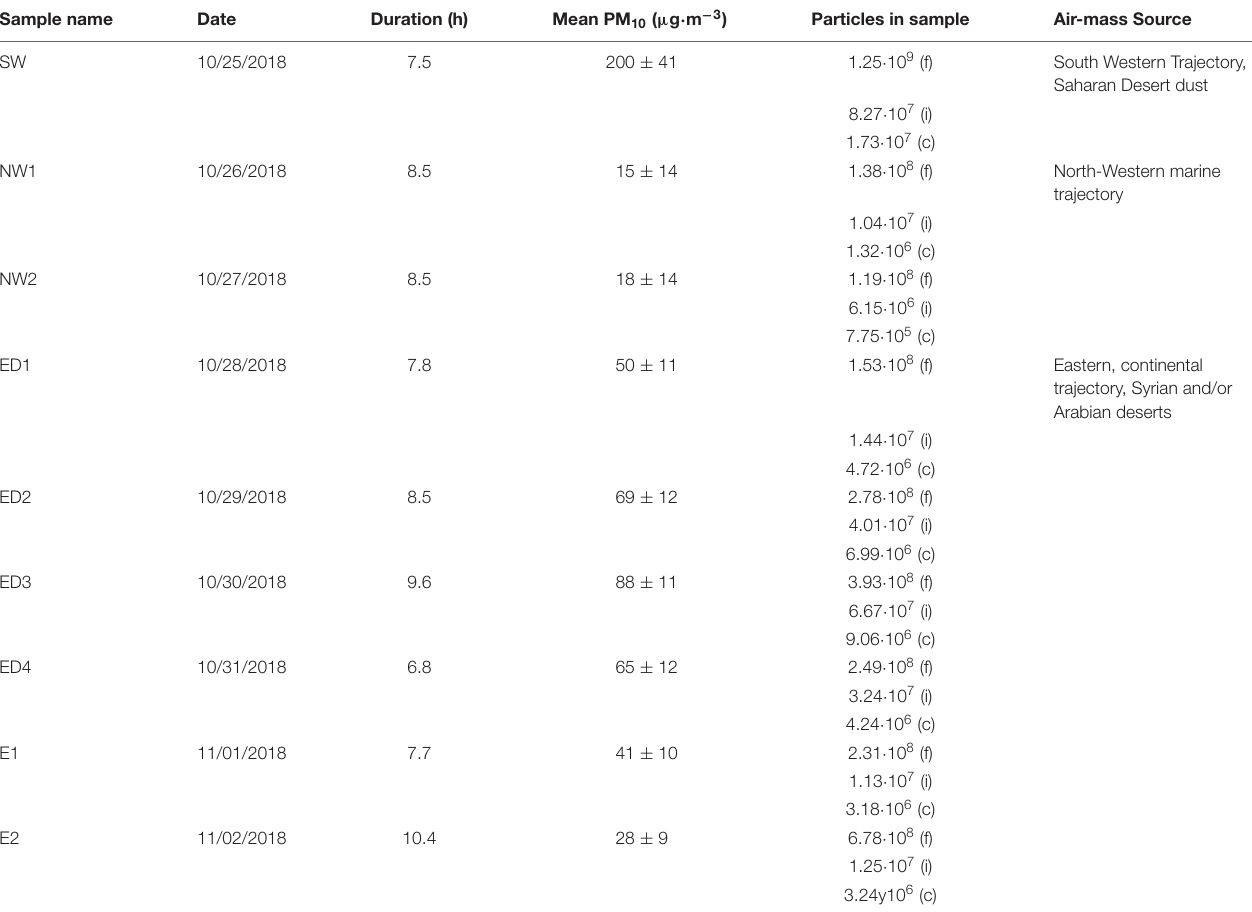
TABLE 1 | List of aerosol samples, their sources and PM 10